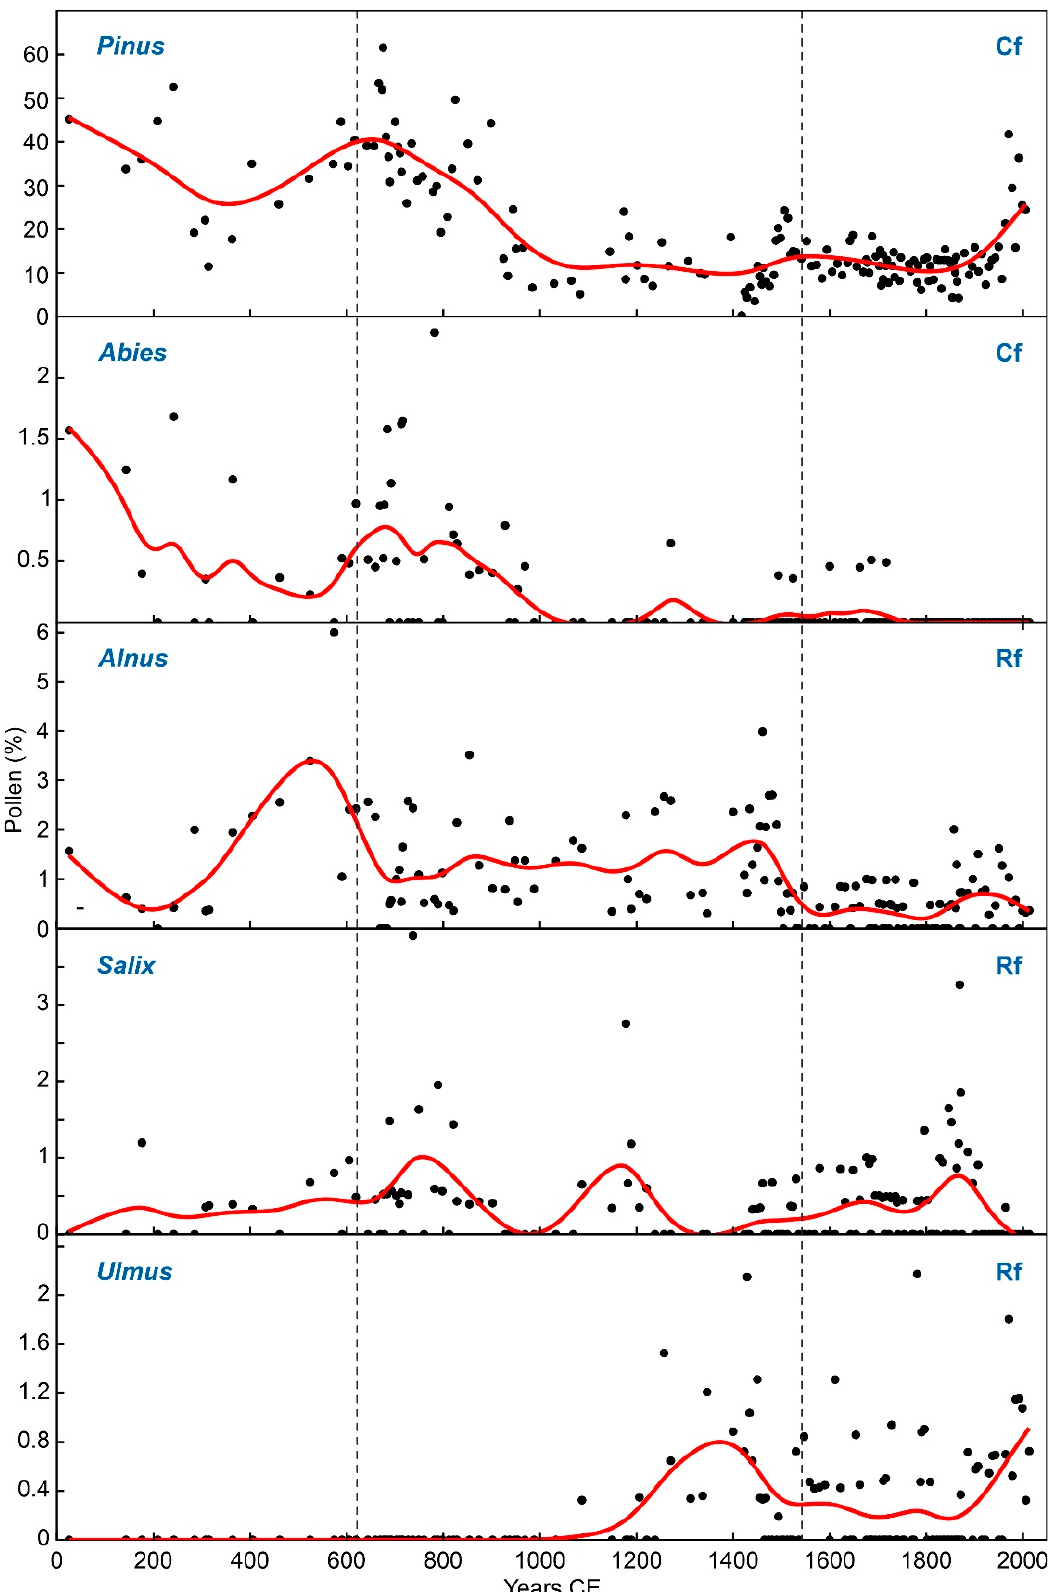
Figure 9. Pollen types of coniferous forest (Cf) and riverine forest (Rf). Black dots: raw data, red line: smoothing spline.